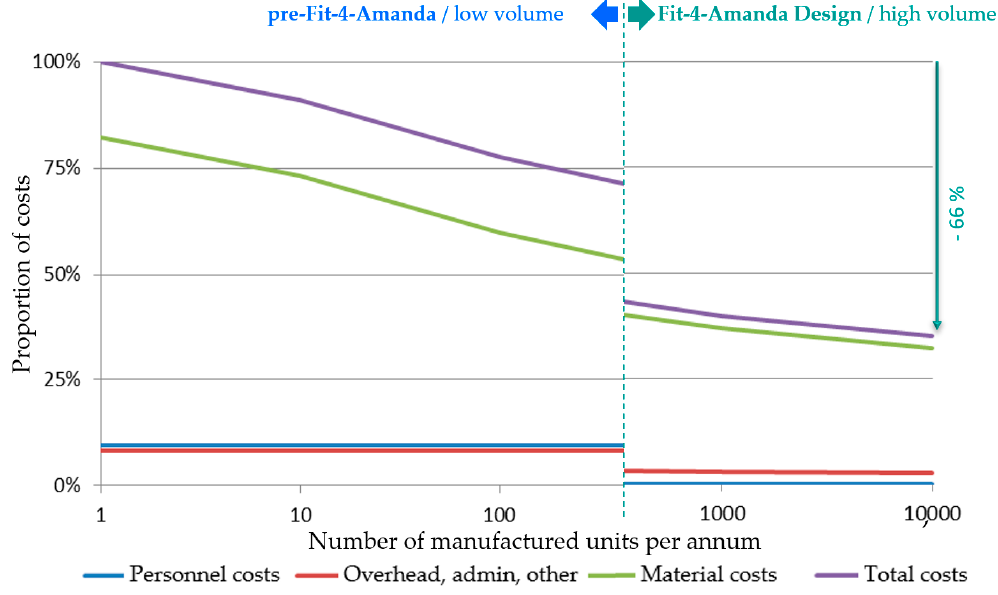
Figure 10. Prospects for stack manufacturing costs for higher volumes.